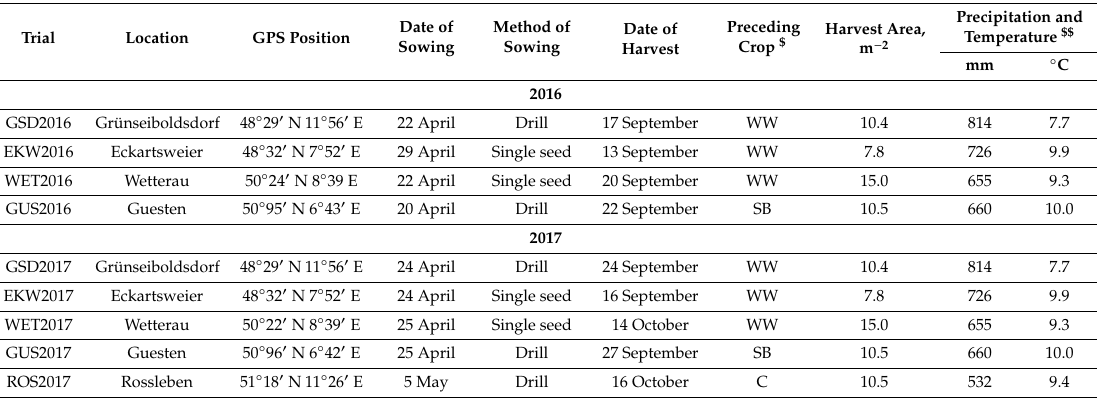
Table 1. Characterization of locations and cropping